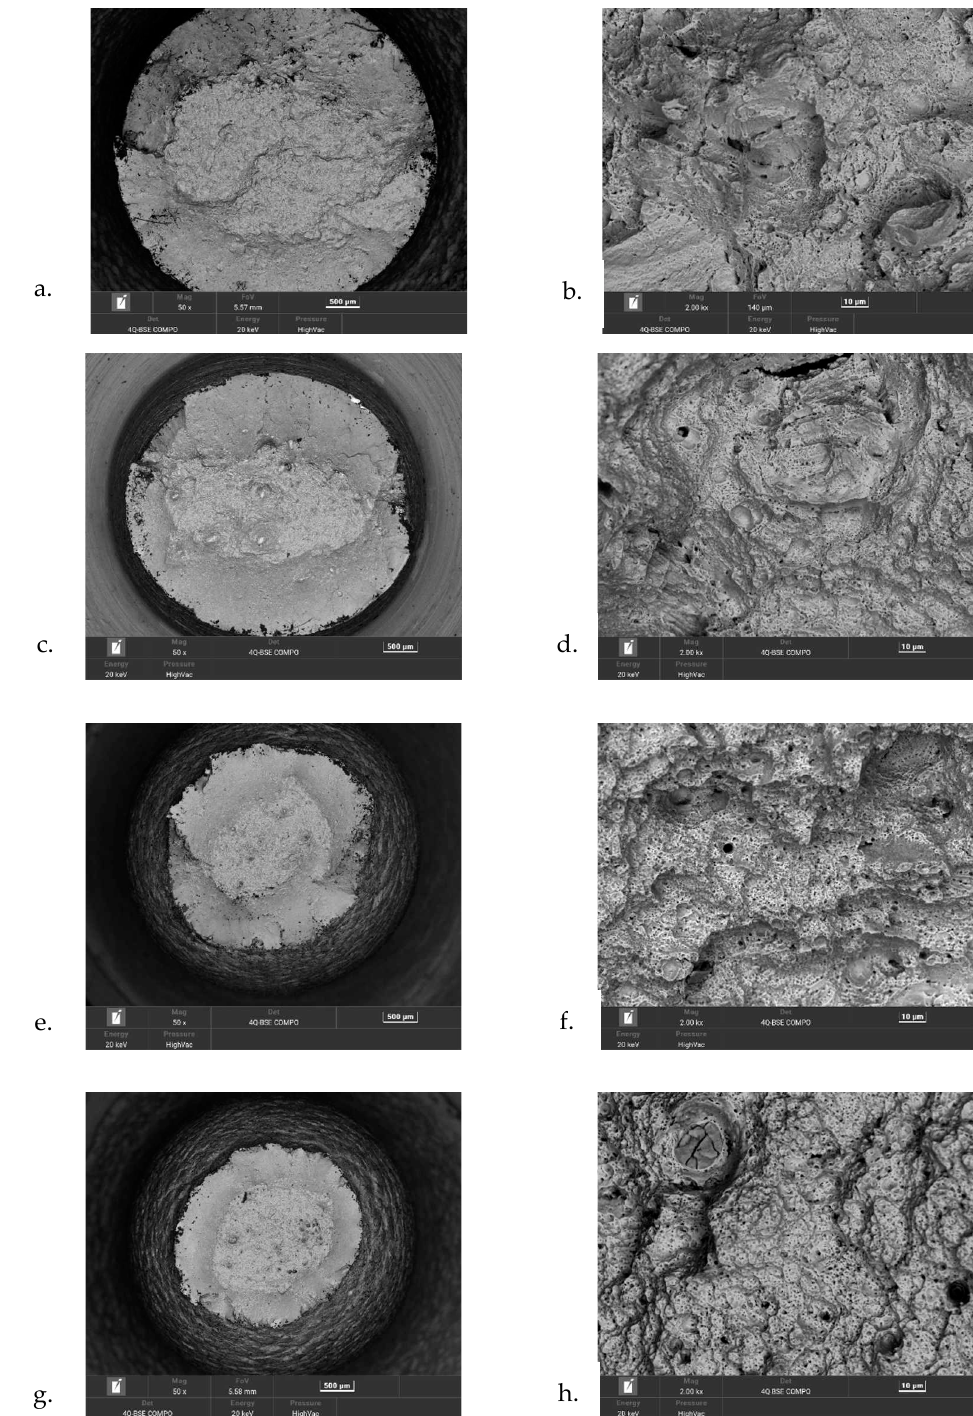
Figure 5. Images of the fracture surface morphology of samples taken with a scanning microscope after static tensile testing was conducted: ( a , b )—200 °C; ( c , d )—300°C; ( e , f )—470 °C; ( g , h )—550 °C.